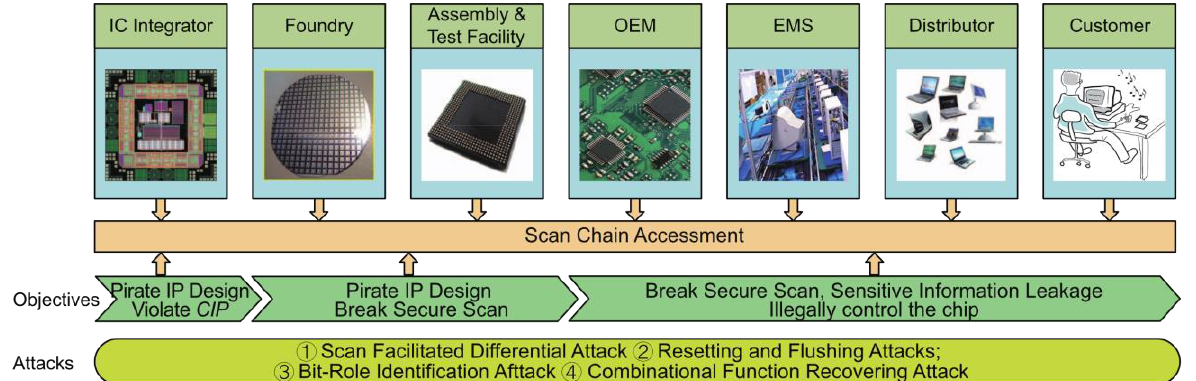
Figure 33. Attacker’s objectives throughout integrated circuit (IC) supply chain [117]. Abbreviations used: IC, Integrated Circuit; OEM, Original Equipment Manufacturer; EMS, Electronics Manufacturing Services; and IP, Intellectual Property. Reprinted with permission from ref. [117]. 2017 Institute of Electrical and Electronics Engineers.